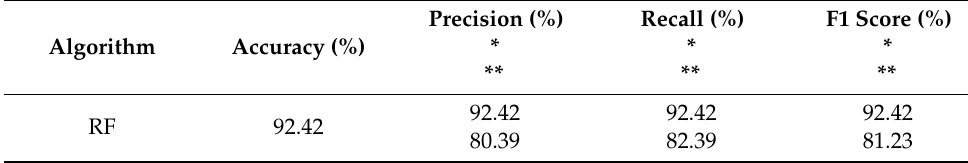
Table 4. AL size selection test